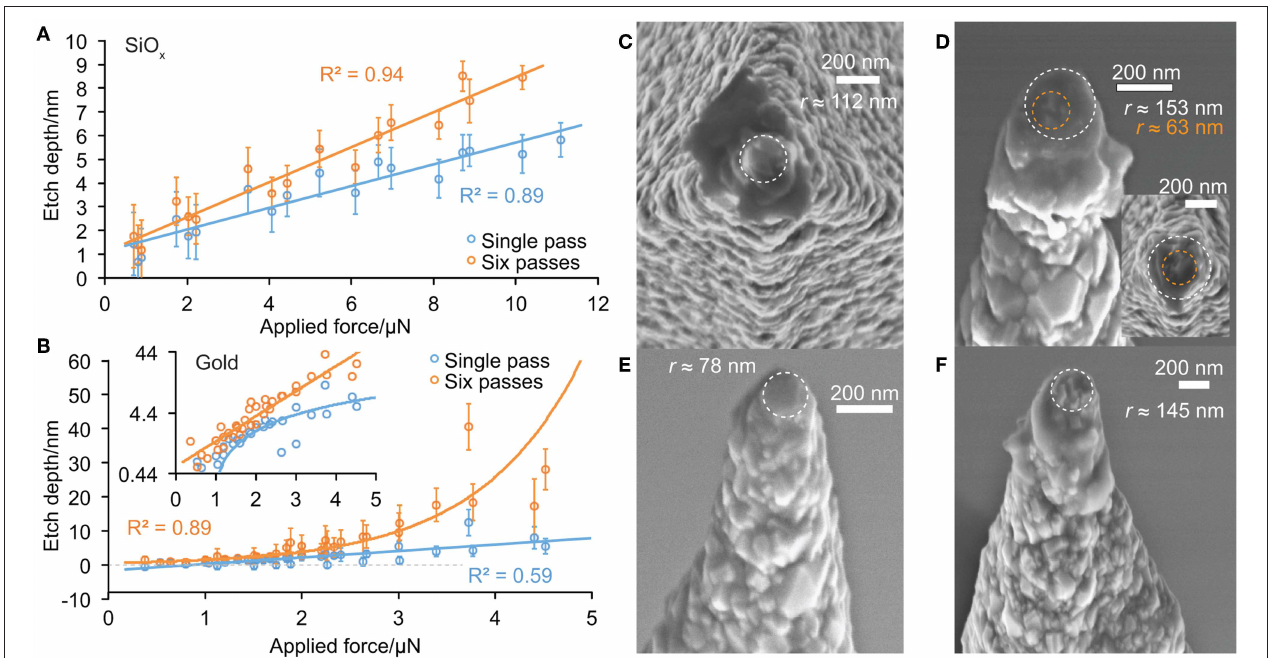
FIGURE 6 | Etching consistency between multiple probes and SEM images of probes following use. (A) Aggregated etch depth with applied force data for single and sets of six passes on SiO x , fitted with linear functions. (B) Aggregated etch depth with applied force for gold, in which the data for single and sets of six passes have been fitted with linear and exponential functions, respectively. Inset—log y-axis plot of the same data. (C,D) Two probes following etching on SiO x . A top-down view is shown in (C) . Some debris appears to have accumulated near each apex. The apex is obscured in (D) , making it difficult to discern whether the larger (dashed white circle) or smaller (dashed orange circle) highlighted area corresponds to the true apex. Inset—top-down view of the apex in (D) . It appears that the larger r likely describes the apex, but with multiple central protrusions present. (E,F) Two probes following etching on gold. Little debris is present and the apex in (E) appears to have less well-defined grains than an unused probe, so we suppose that wear occurs on both hard and soft samples, though more gradually for the latter.